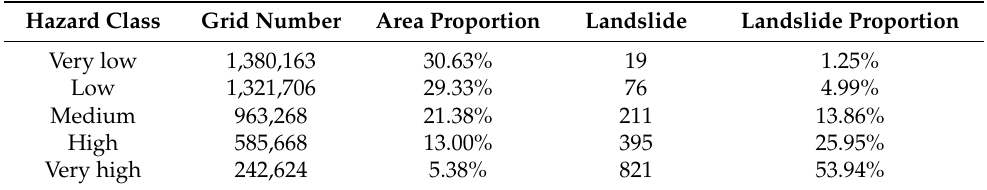
Table 7. Statistical result of landslide hazard in different classes.